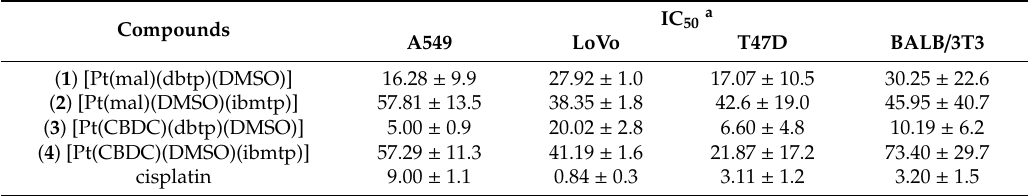
Table 5. In vitro antiproliferative activity of platinum(II) complexes (in µ